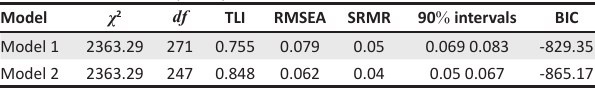
TABLE 2: Factor loadings for the six-factor model of 29 items – first iteration. Item